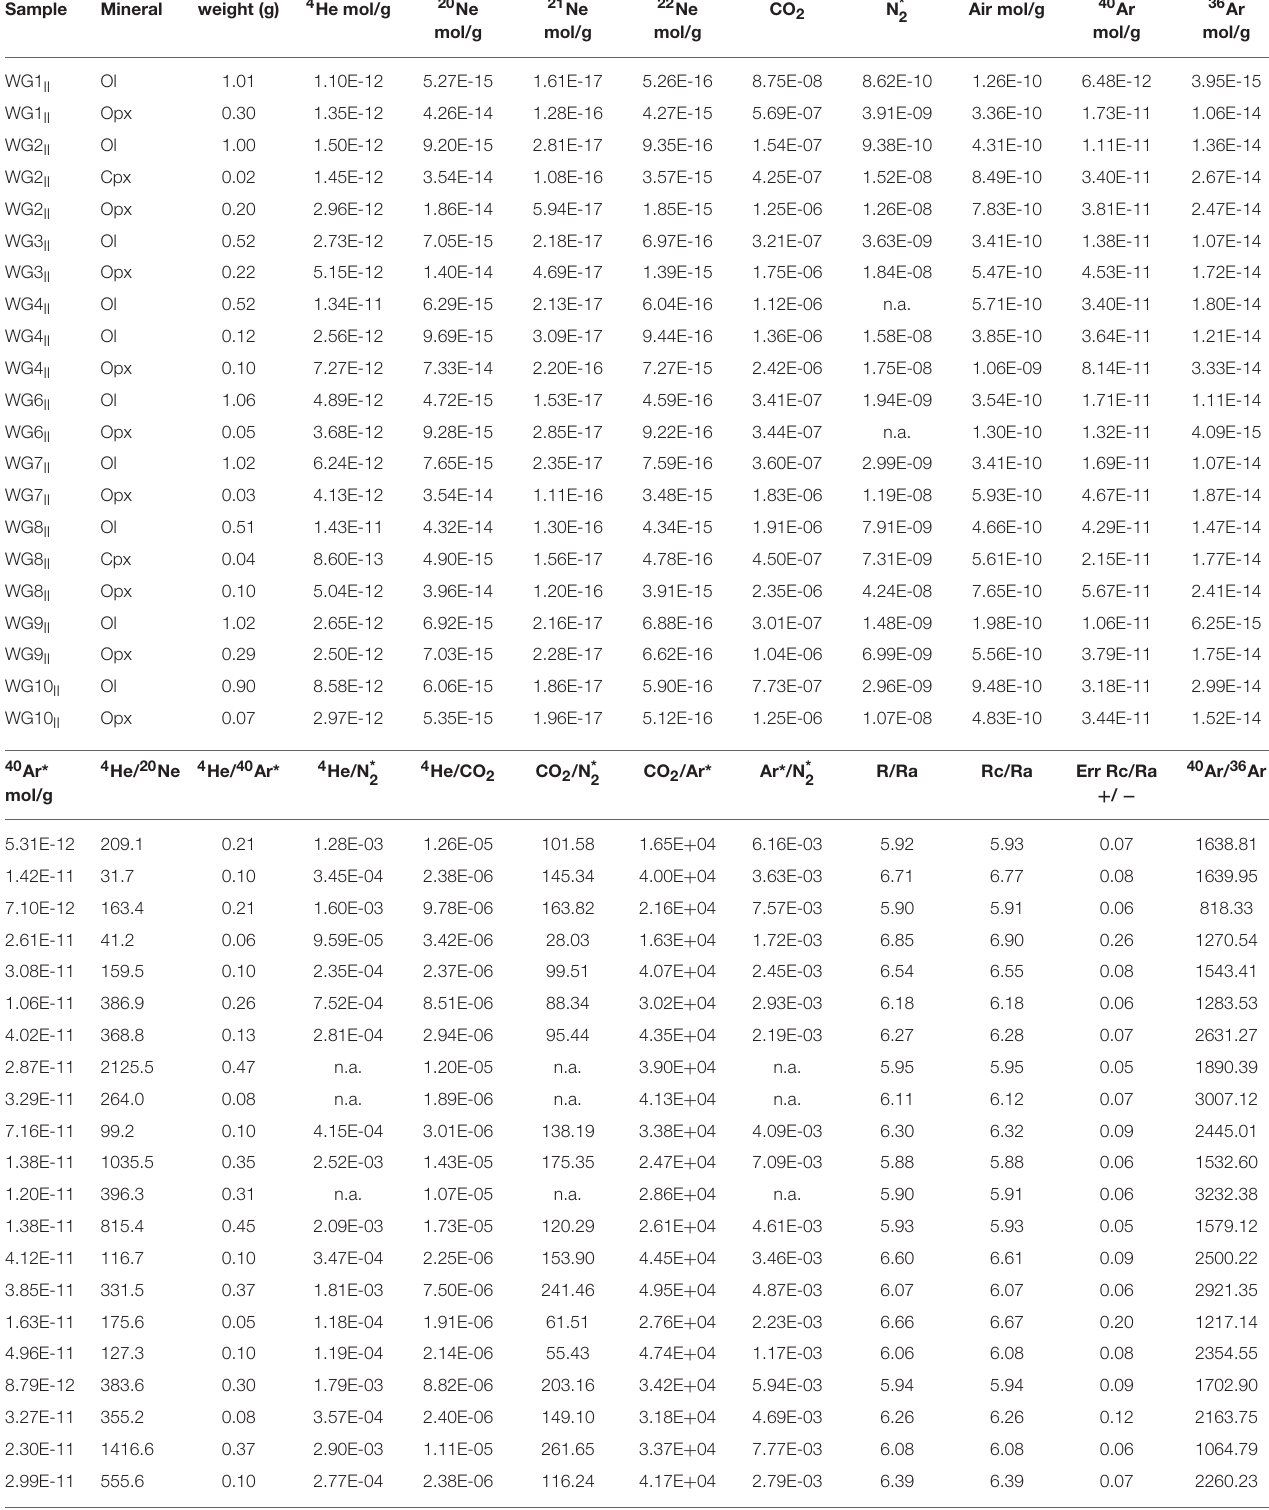
TABLE 3 | Geochemistry of fluid inclusions hosted in minerals forming mantle xenoliths from Wilcza Góra. Sample